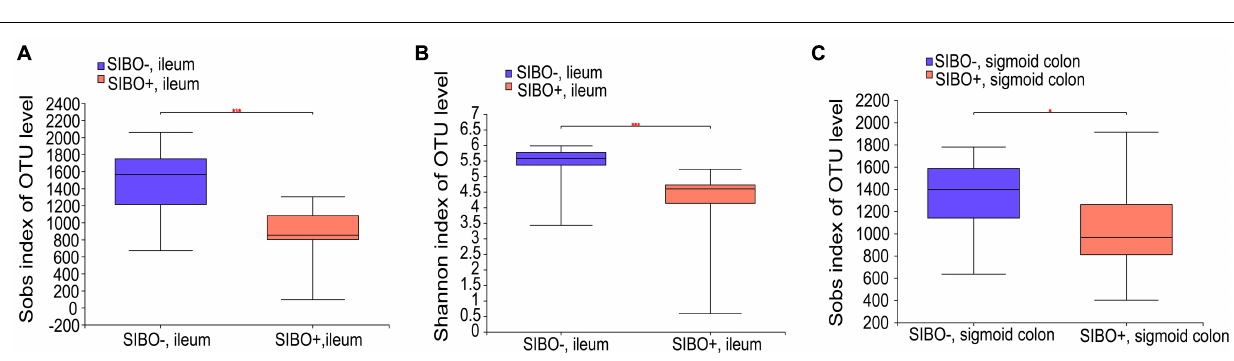
FIGURE 4 | Microbial richness and diversity of the mucosa-associated microbial community in the SIBO + and SIBO − subjects. (A,B) The Sobs richness and Shannon diversity indices of the ileac mucosal samples were significantly lower in the SIBO + subjects compared to the SIBO − subjects. (C) The Sobs richness index of the mucosal samples of the sigmoid colon was significantly lower in the SIBO + subjects than in the SIBO − subjects. * P < 0.05 and *** P <